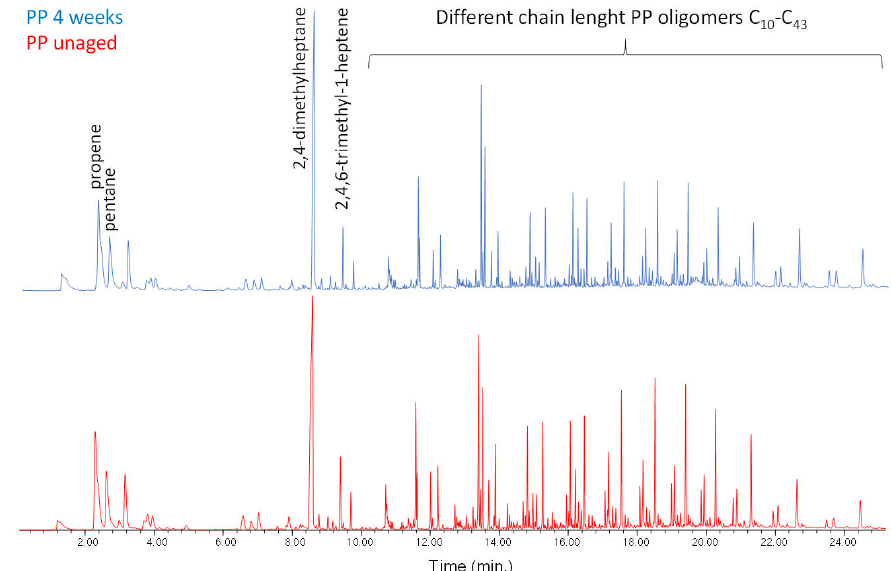
Figure 17. Chromatograms obtained in the Py–GC–MS analysis of the extraction residues of PP-0w (red) and PP-4w (blue). The complete list of the main pyrolysis products is reported in Table S14 in the Supplementary